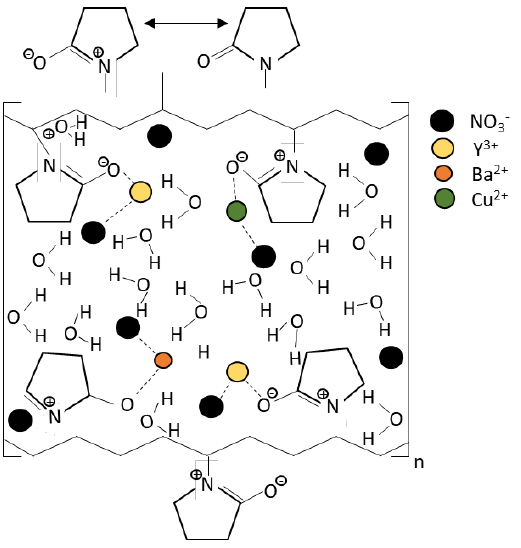
Figure 1. Proposed mechanism of interaction between the PVP and the metal ion [13].